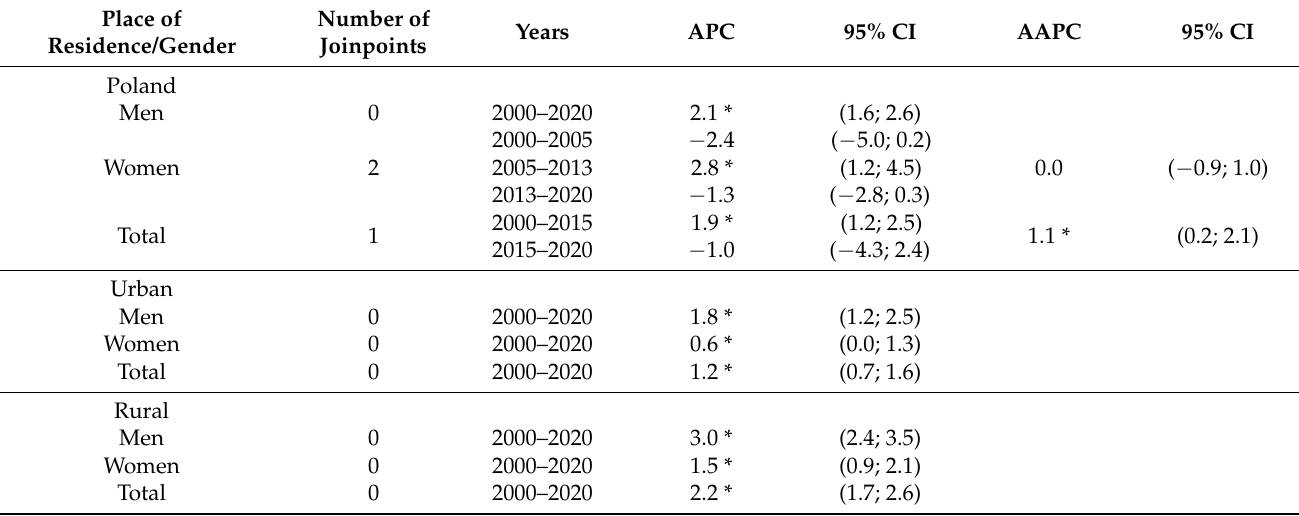
Table 7. Time trends of SDR due to skin melanoma by gender and place of residence in Poland in 2000–2020—results of the joinpoint regression